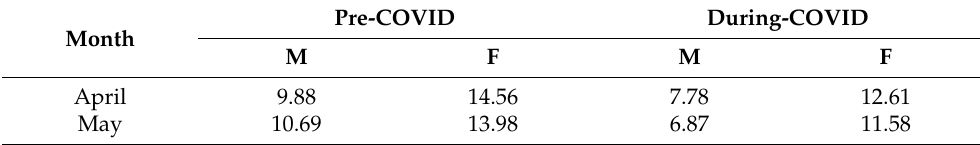
Table 3. The most statistically significant months when comparing physical activity in the pre- COVID and during-COVID periods and comparing the average activity between male (M) and fe- male (F).